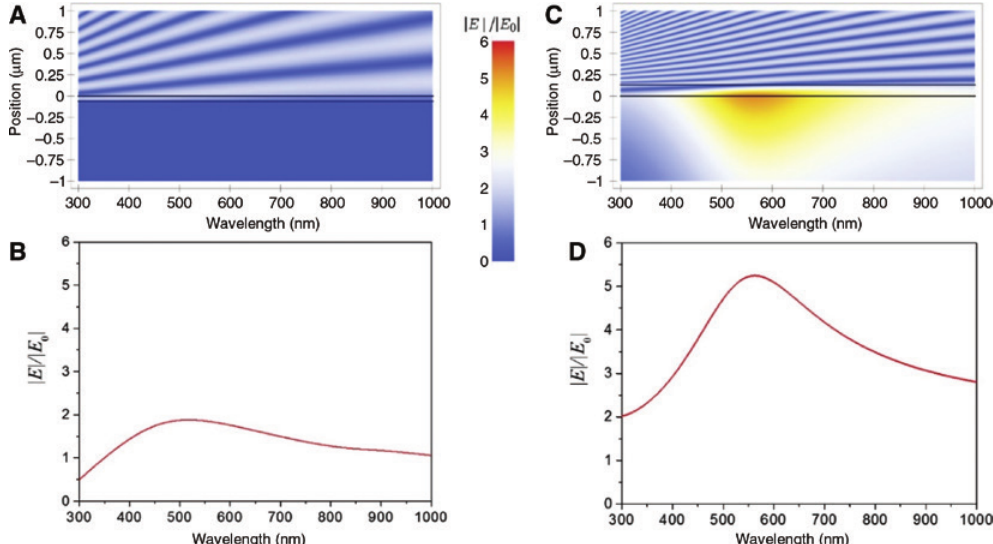
Figure 3: Electric field enhancement in dependence of the wavelength and corresponding electric field maps. (A) Electric field distribution for a 60-nm-thick layer of inorganic glass with n the surface of the layer in dependence of the wavelength. (C) Electric field distribution for the suggested interference-enhanced internal reflection Raman scattering substrate (130 nm layer of an inorganic glass with n incidence angle of 18.85 ° and s-polarized light. (D) Electric field on the surface of the inorganic glass layer for the same conditions as in (C). Adapted and reprinted with permission from [10]. © Copyright 2018 American Chemical